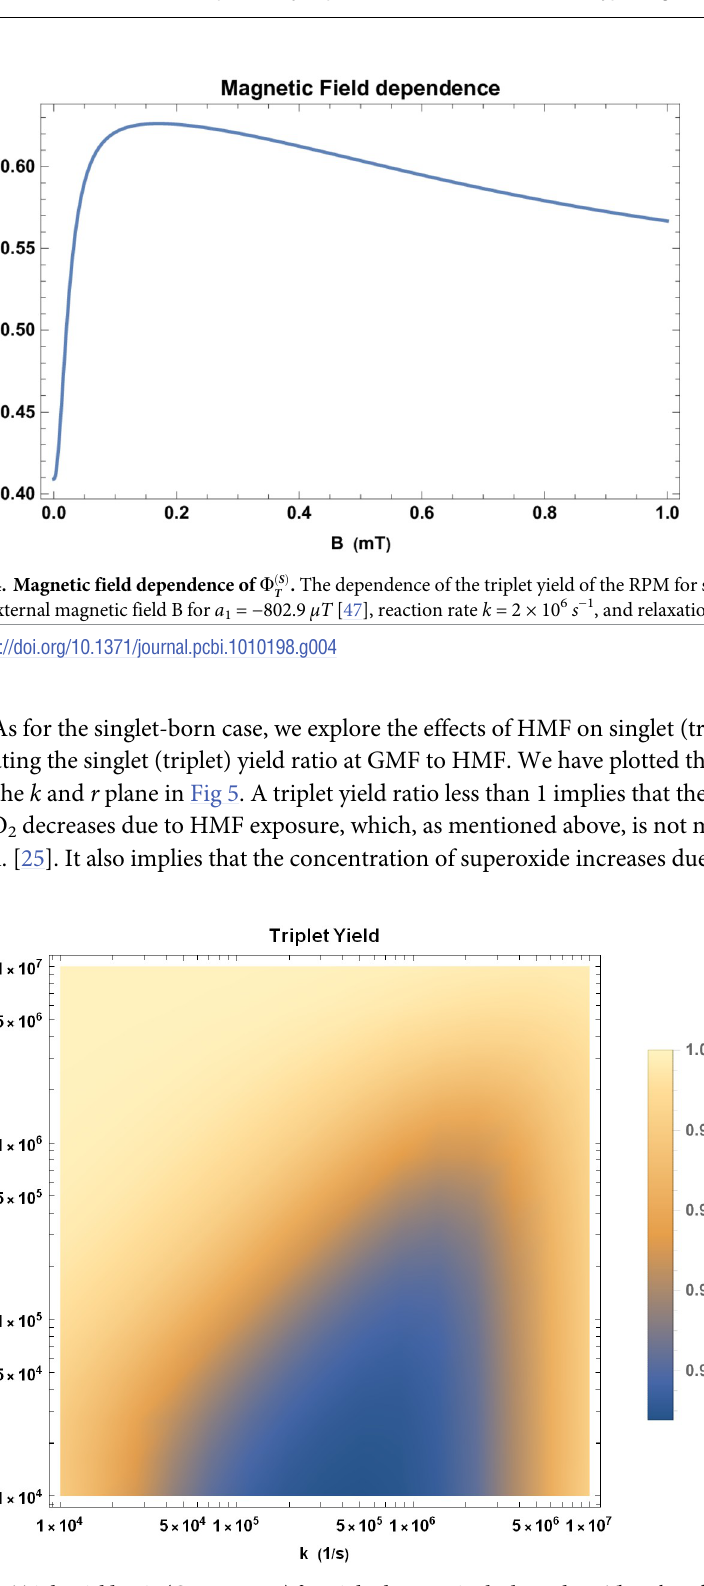
Fig 5. Triplet yield ratio (GMF to HMF) for triplet-born RP in the k − r plane. The value of HFCC a 1 is taken to be a 1 = − 802.9 μT